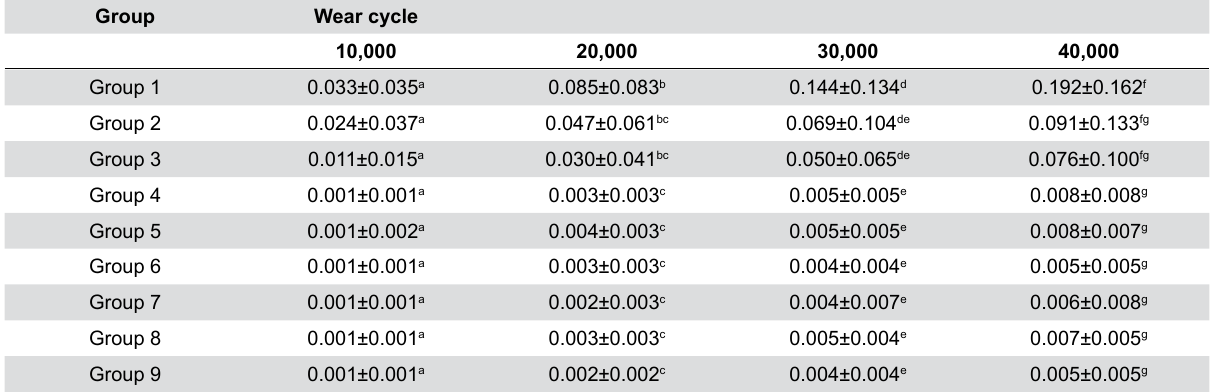
Table 1- Wear volumes of materials at each wear cycle (Mean±SD, Unit: mm 3